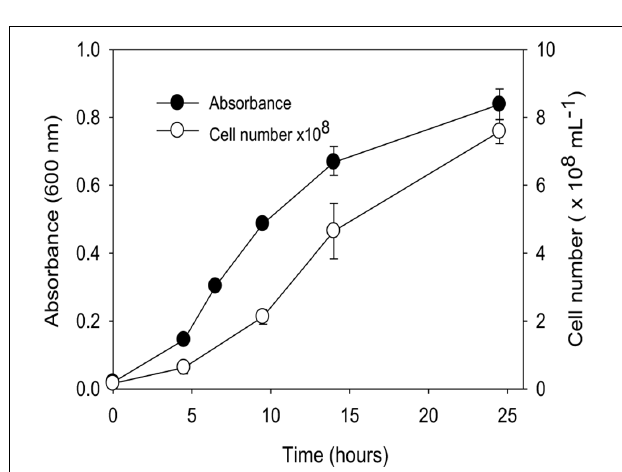
FIGURE 2 | Growth curve of “ P. lilae ” UFO1 on R2A broth supplemented with 20 mM fumarate at 30 ◦ C. Symbols are means of triplicate analyses, and error bars indicate ± 1 standard